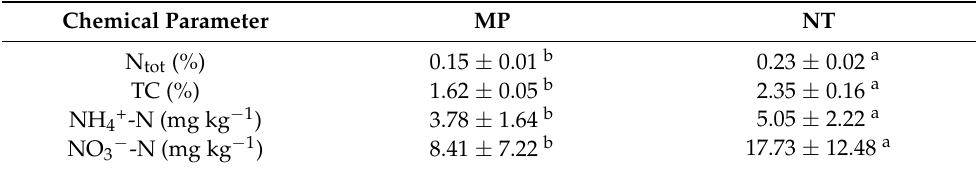
Table 13. Mean values of soil chemical parameters of the field experiment. Chemical Parameter